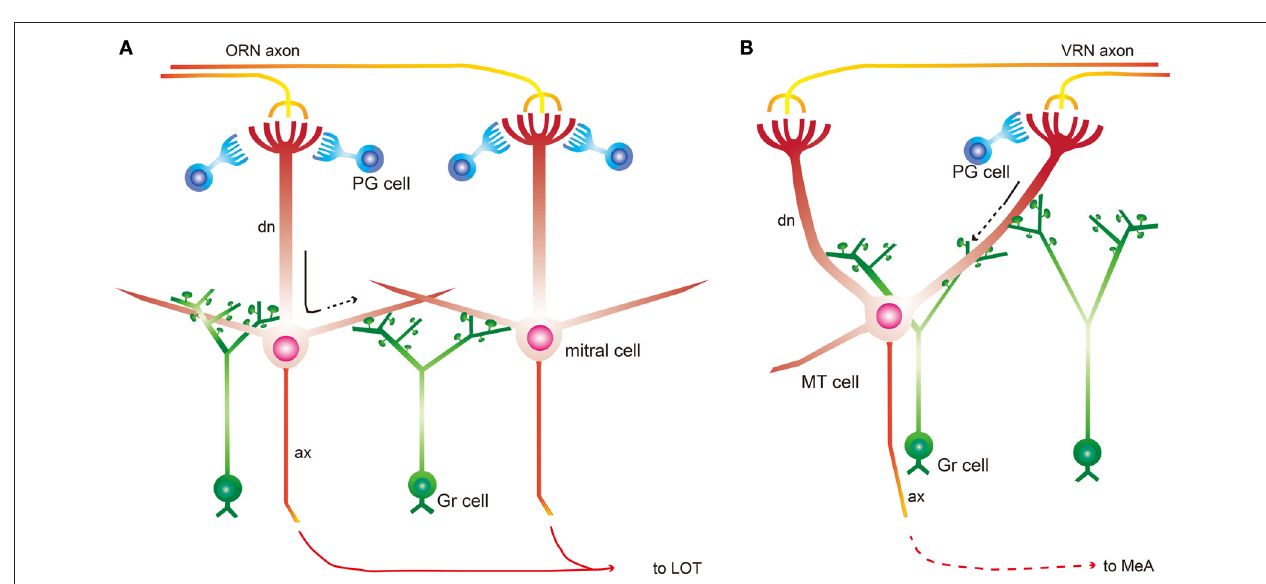
FIGURE 4 | Schematic summarizing RS location and function. (A) A simplified model of the MOB intrabulbar circuit. Mitral cells receive odor input from olfactory receptor neurons (ORN) and then send olfactory information to the olfactory cortex through the lateral olfactory tract (LOT). Mitral cells receive inhibitory input from mainly periglomerular (PG) and Gr cells. Gr cell spines form RSs with mitral cells primarily on secondary dendrites. This dendrodendritic signaling is driven by mitral cell soma depolarization. RSs act through lateral inhibition and self inhibition after depolarization for effective discrimination. Black arrow indicates the